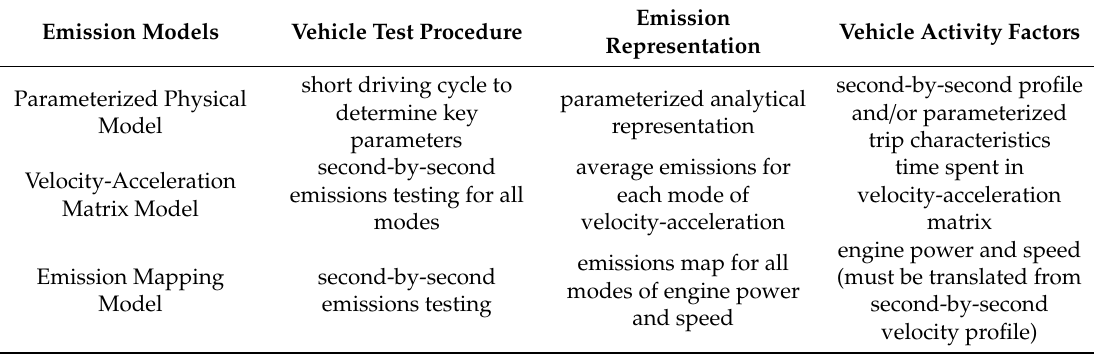
Table 2. Characteristics of several mainstream emission